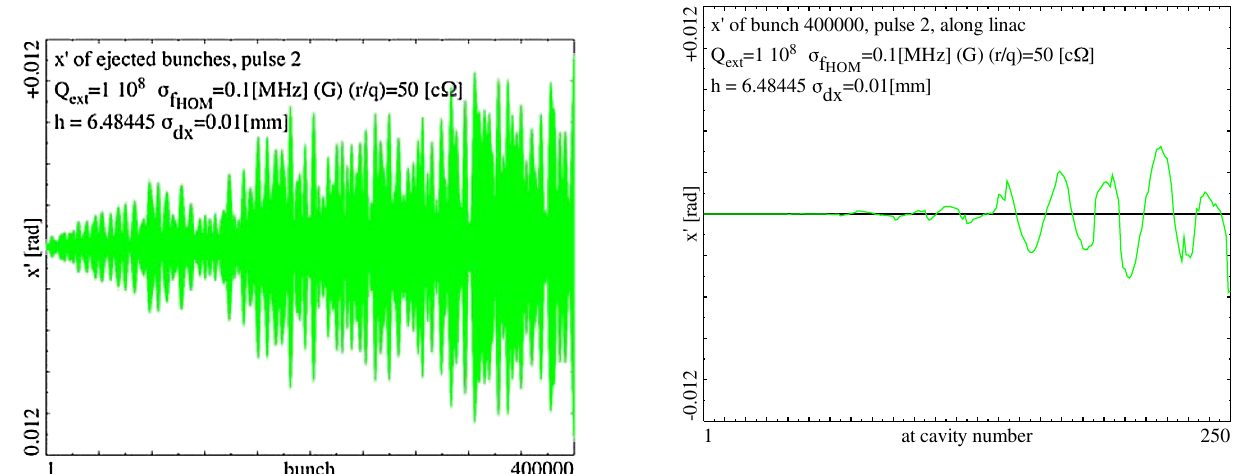
FIG. 52. (Color) x 0 [rad] of the last bunch, conditions as in Fig.